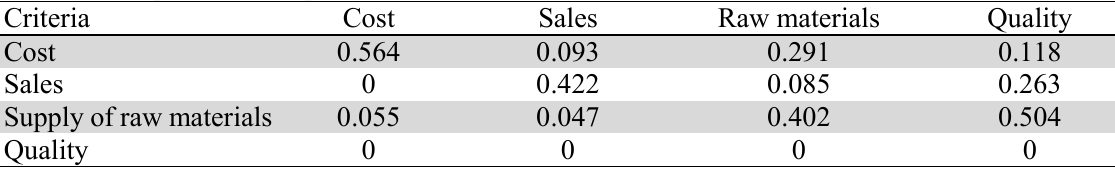
The results of pairwise comparison in section B